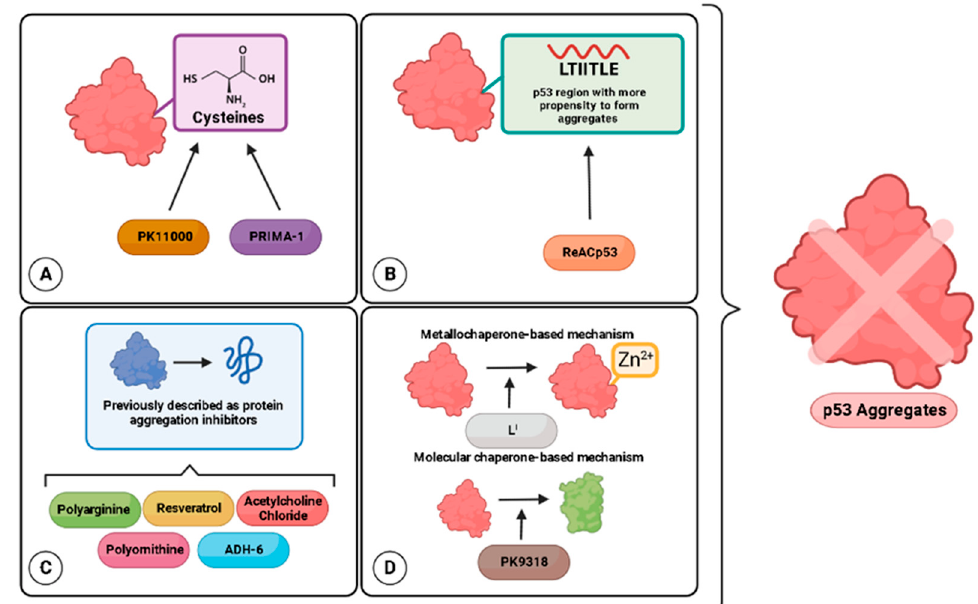
Figure 1. Strategies to target p53 aggregation as anticancer candidates. ( A ) Thiol alkylating agents targeting mutp53 cysteines. ( B ) Designed peptides that bind in a complementary way to regions of p53 with a greater propensity to aggregate. ( C ) Miscellaneous compounds with anti-protein aggregation properties previously tested in neurodegenerative diseases. ( D ) Compounds with metallochaperone- or molecular-chaperone-based mechanisms.